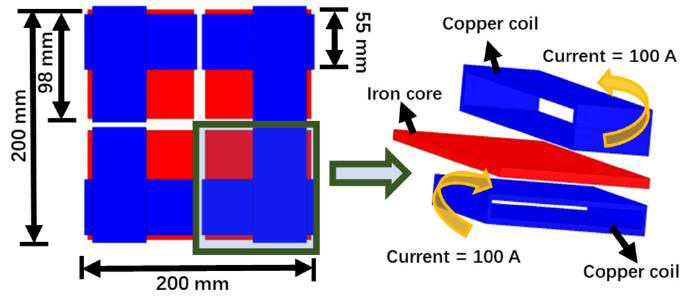
Figure 6. Magnetic field distribution of cross coupling coils.